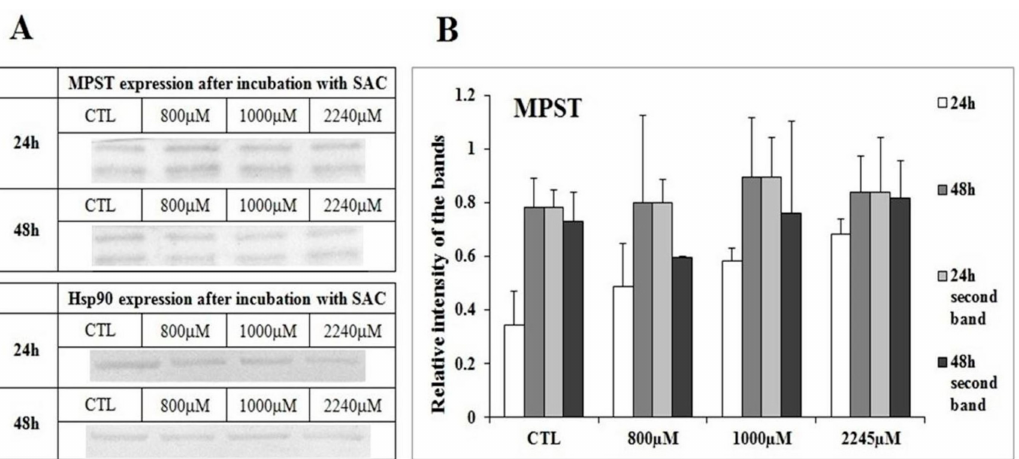
Figure 4. The expression of 3-mercaptopyruvate sulfurtransferase (MPST) in the breast cancer cell line (MCF-7) after the 24 h and 48 h incubations with SAC. The tested concentrations of SAC in culture medium as listed: 800 µ M, 1000 µ M and 2245 µ M, while the control refers to non-treated cells. ( A ) Western blot with immunodetection. Each experiment was done tree times in triplets, and a representative experiment is shown. Hsp90 is used as a control of equal loading. ( B ) Densitometric visualization of expression of MPST. The error bars represent standard